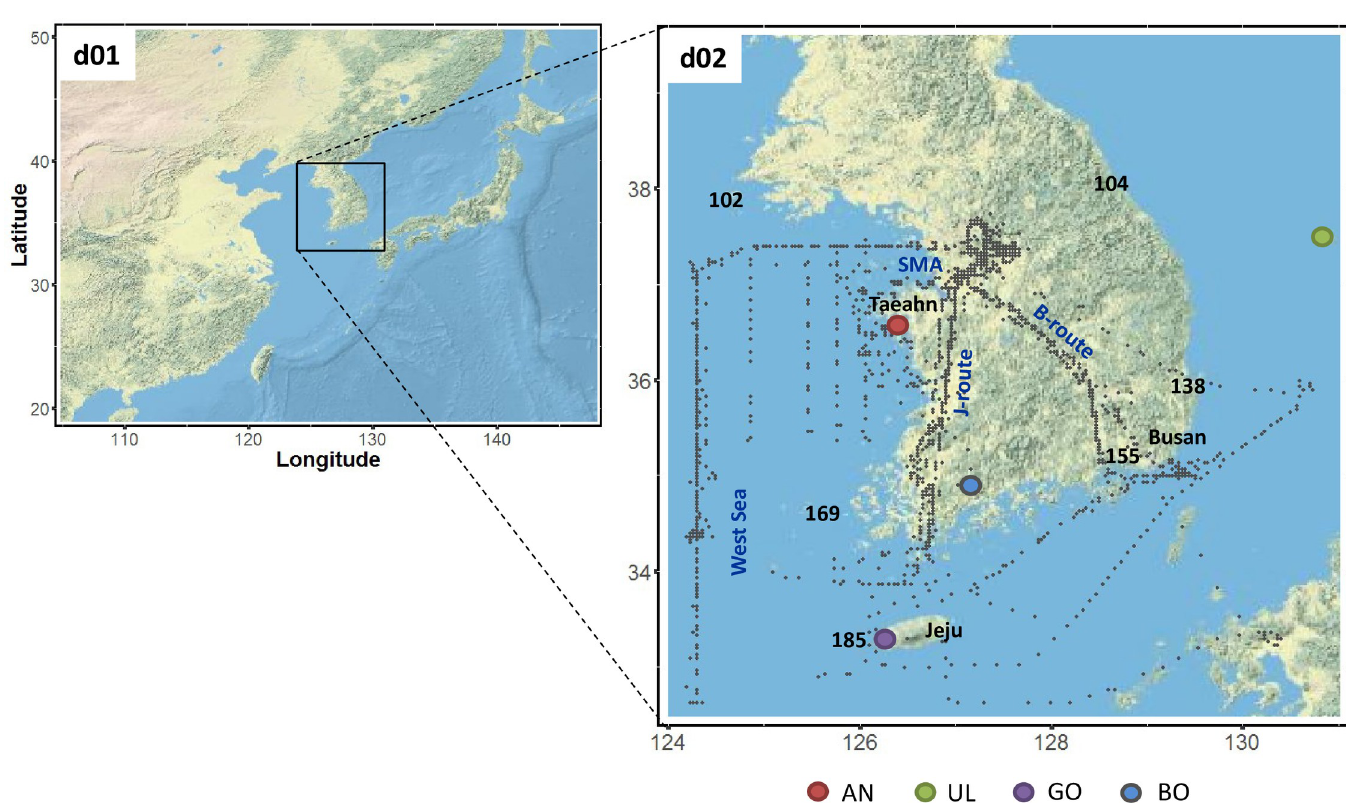
Fig 1. Domains for WRF-VPRM modeling framework. In the fine domain (d02), the DC-8 aircraft 6-min flight tracks marked as dots, and the ground CO 2 measurement sites are marked with color circles. Three-digit numbers indicate KMA’s rawinsonde sites, and names in blue indicate the flight group for the vertical profile.